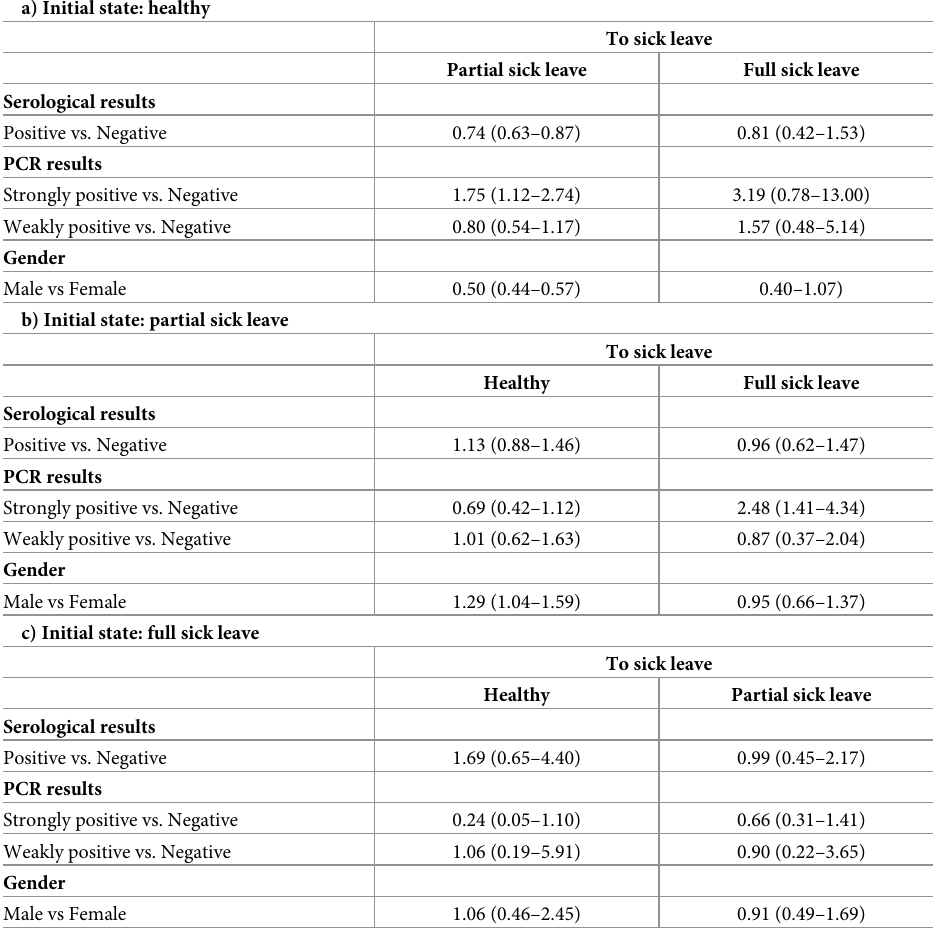
Table 1. Odds ratios of sick leave state after the week of sampling up to calendar week 27 in year